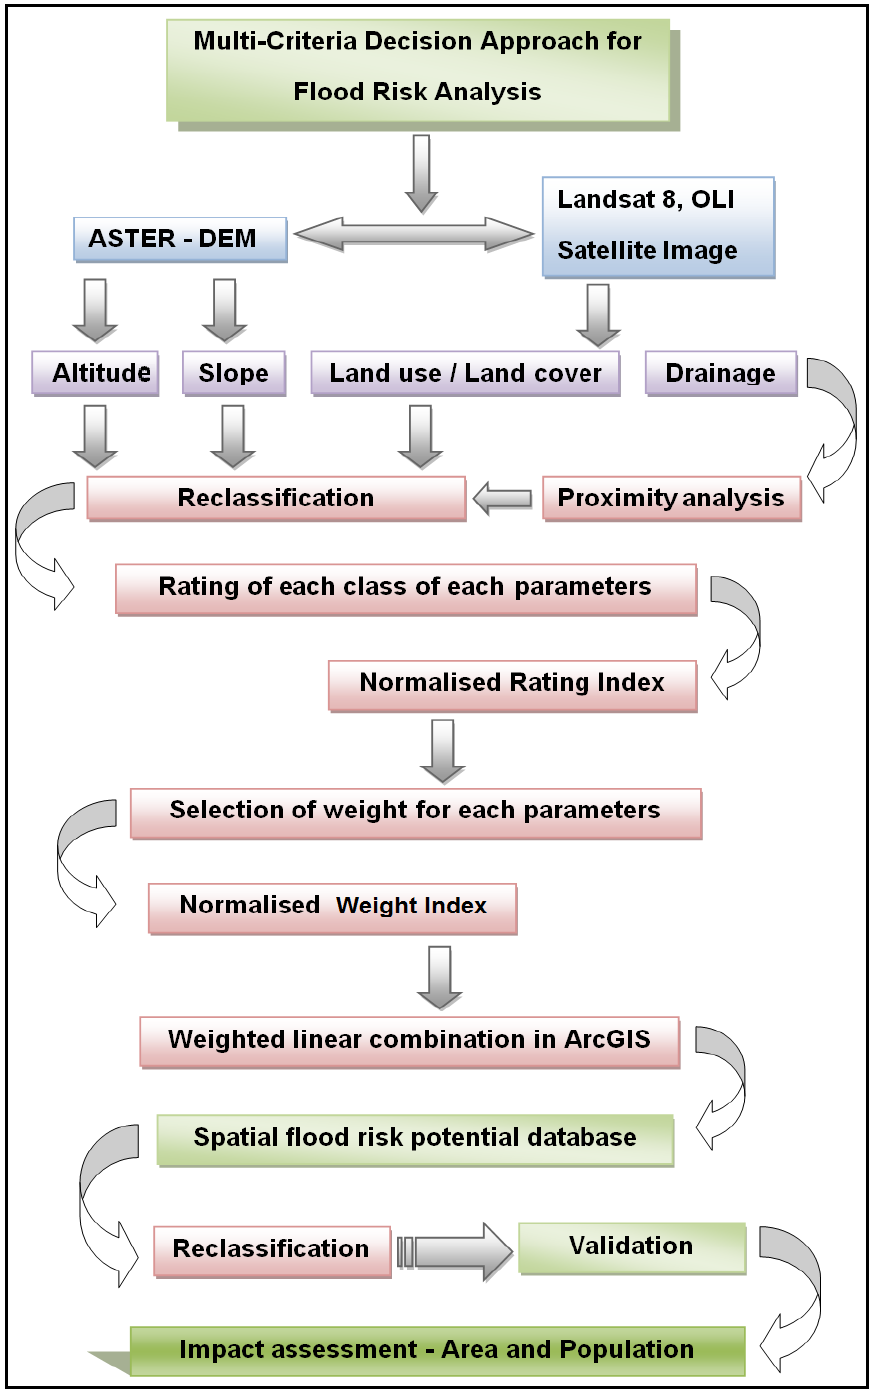
Figure 3. Methodological flow chart for flood risk analysis through MCDA.